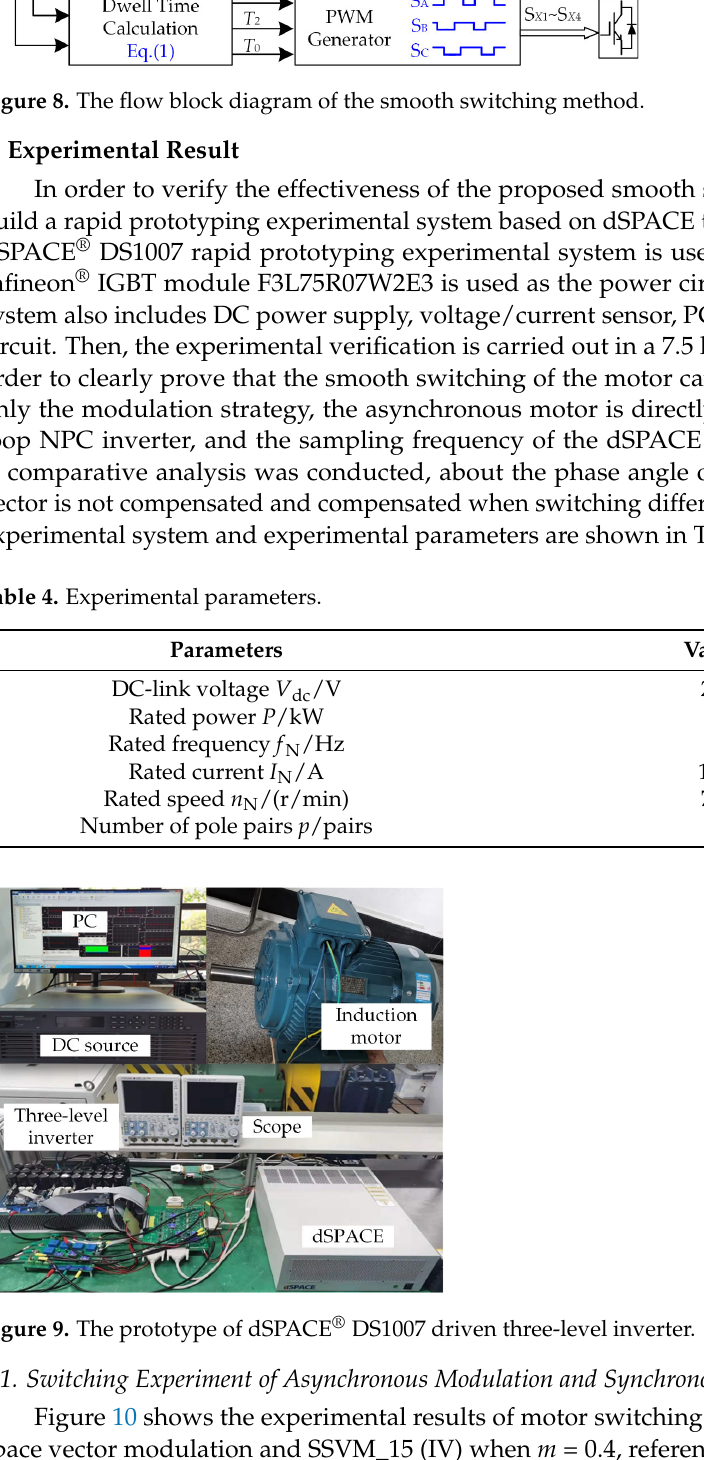
( b ) Figure 10. Experimental results of asynchronous modulation and SSVM_15(IV) switching. ( a ) Asyn- chronous modulation → SSVM_15 (IV). ( b ) SSVM_15 (IV) → asynchronous modulation. 5.2. Switching Experiment of Different Clamping Methods of SSVM